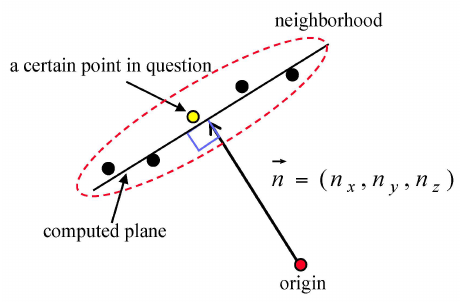
Figure 3. Vector defined from the origin to the computed plane for a given point, using its neighboring